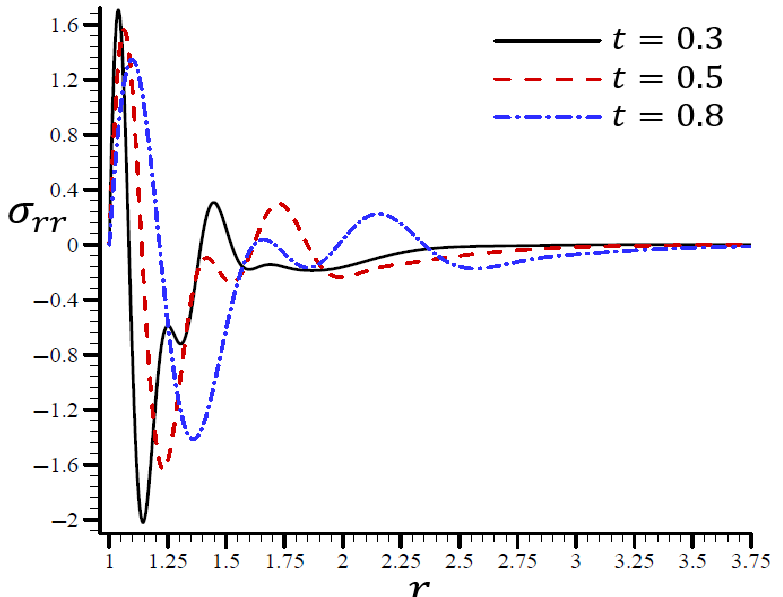
Figure 10. The influence of t on radial stress σ rr through the radial direction of the spherical hole using the RTPL model.